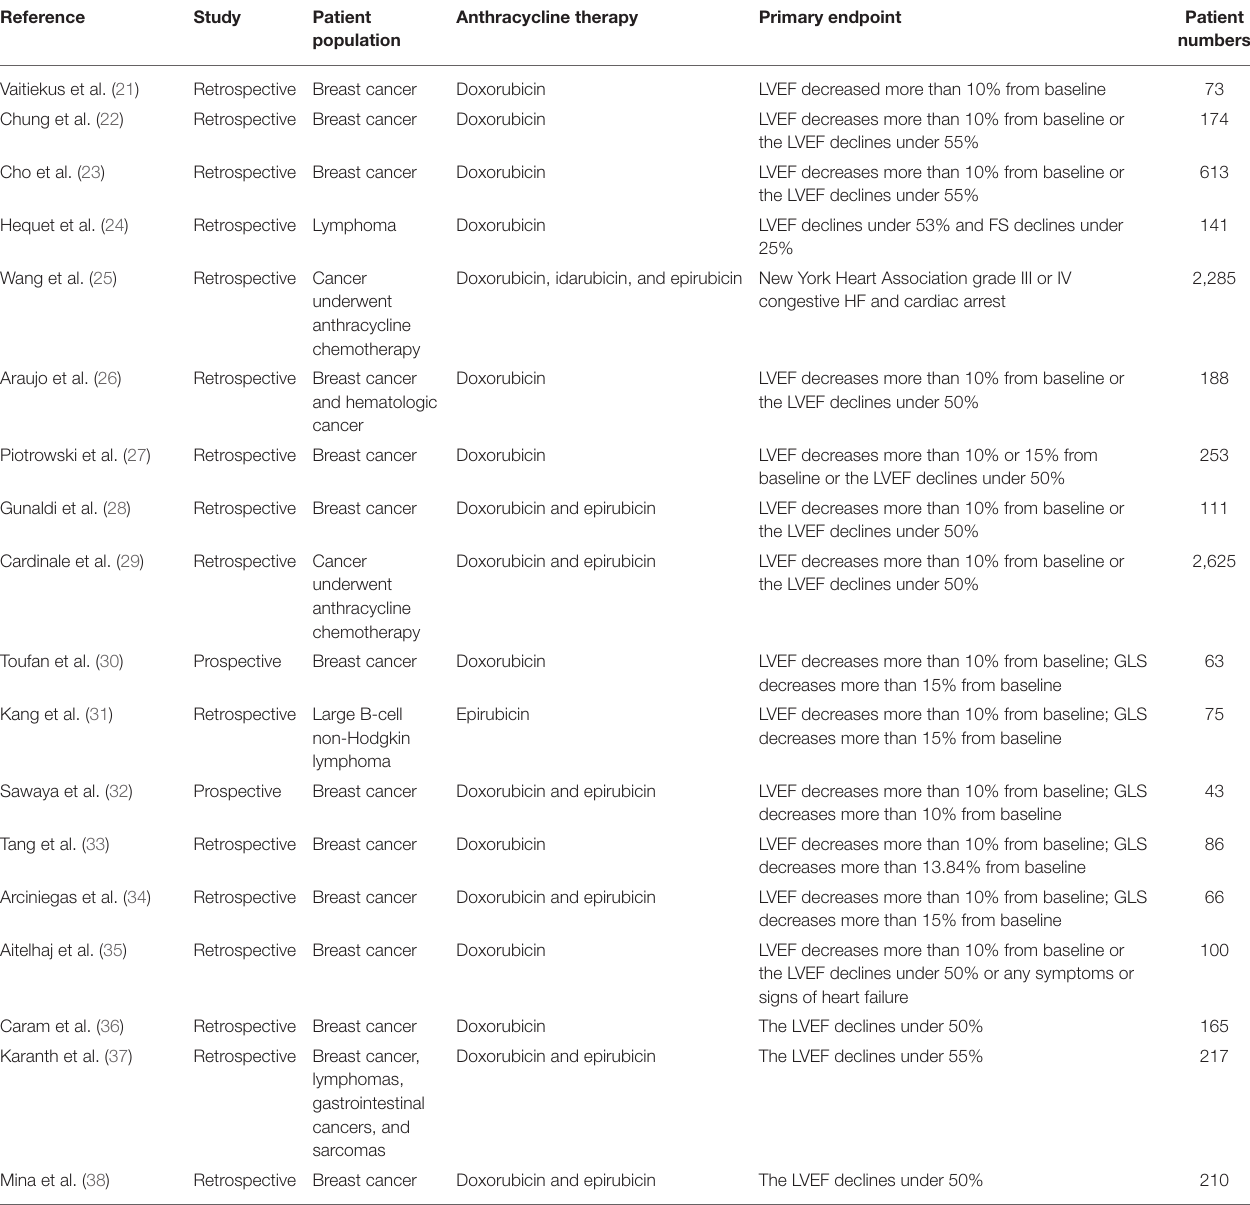
TABLE 1 | Characteristics of the studies and patients included in the